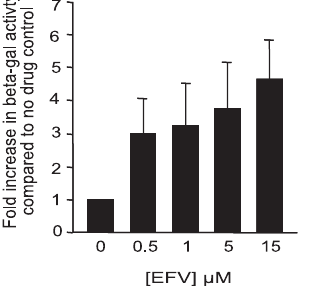
Figure 2. Effect of EFV on a Model Pol Construct in the Y2H System Yeast strain CTY10-5d expressing a model Pol construct as both bait and prey was assayed for b -gal activity in the presence of EFV. Results are expressed as fold increase in b -gal activity compared to the untreated control. Data represent at least three independent assays and are expressed as the mean 6 standard error.